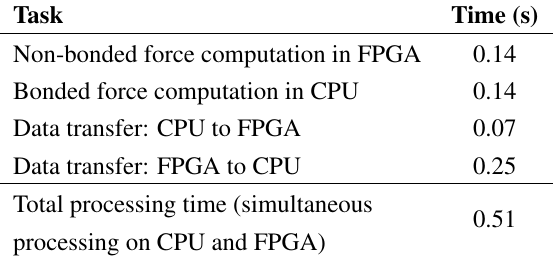
Table 4. Total processing time per one iteration of the heteroge- neous